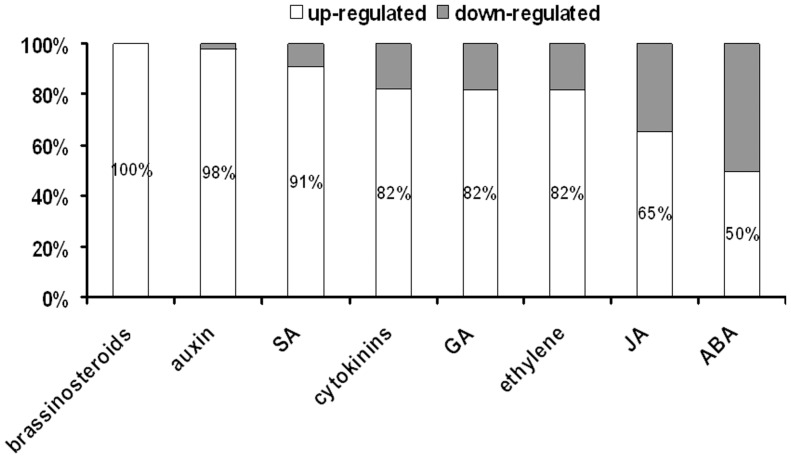
Hormone-related TFs.The graph shows the percentages of hormone-related TFs up- or downregulated in embryogenic Col-0 culture. A great majority of the hormone-related TFs is up-regulated including those related to brassinosteroids, auxin, SA, cytokinins, GA, ethylene, JA and ABA.